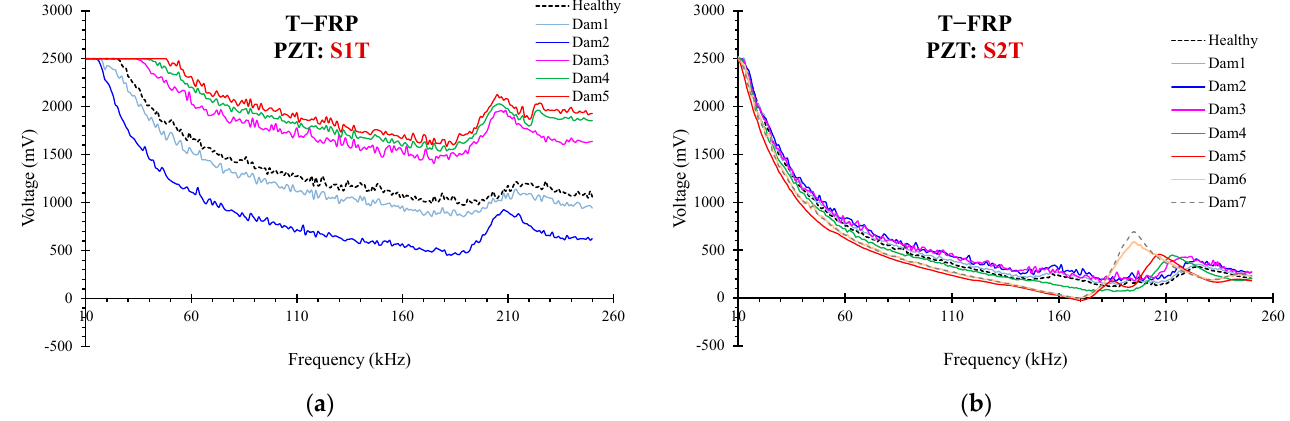
Figure 10. Typical curves of the electro-mechanical signatures of PZT transducers ( a ) S1T and ( b ) S2T.